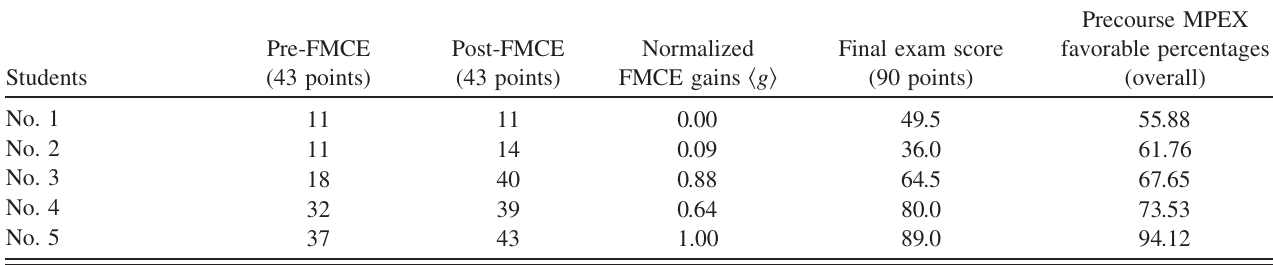
TABLE IV. Performances of students with high favorable precourse effort